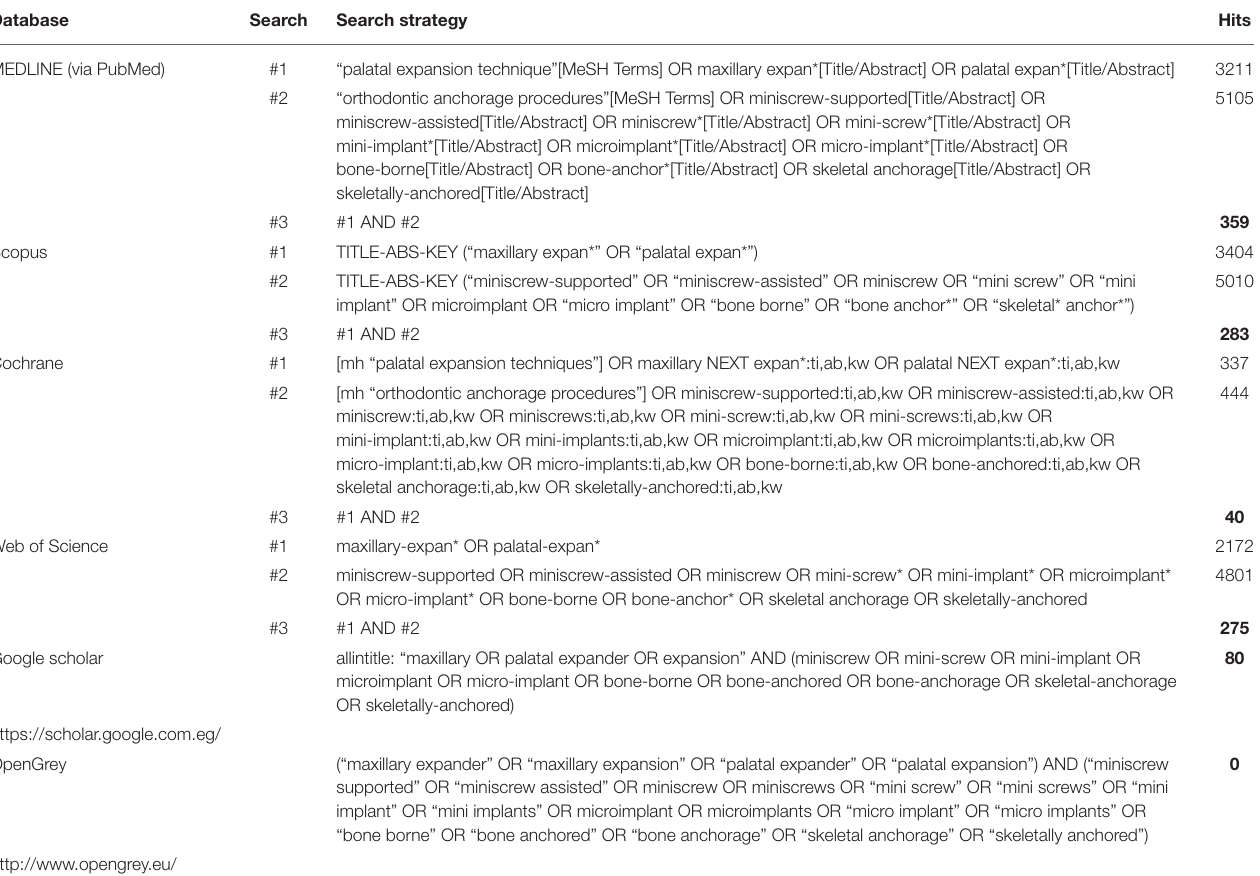
TABLE 1 | Literature search conducted to identify studies (last search date May 7 th , 2020).